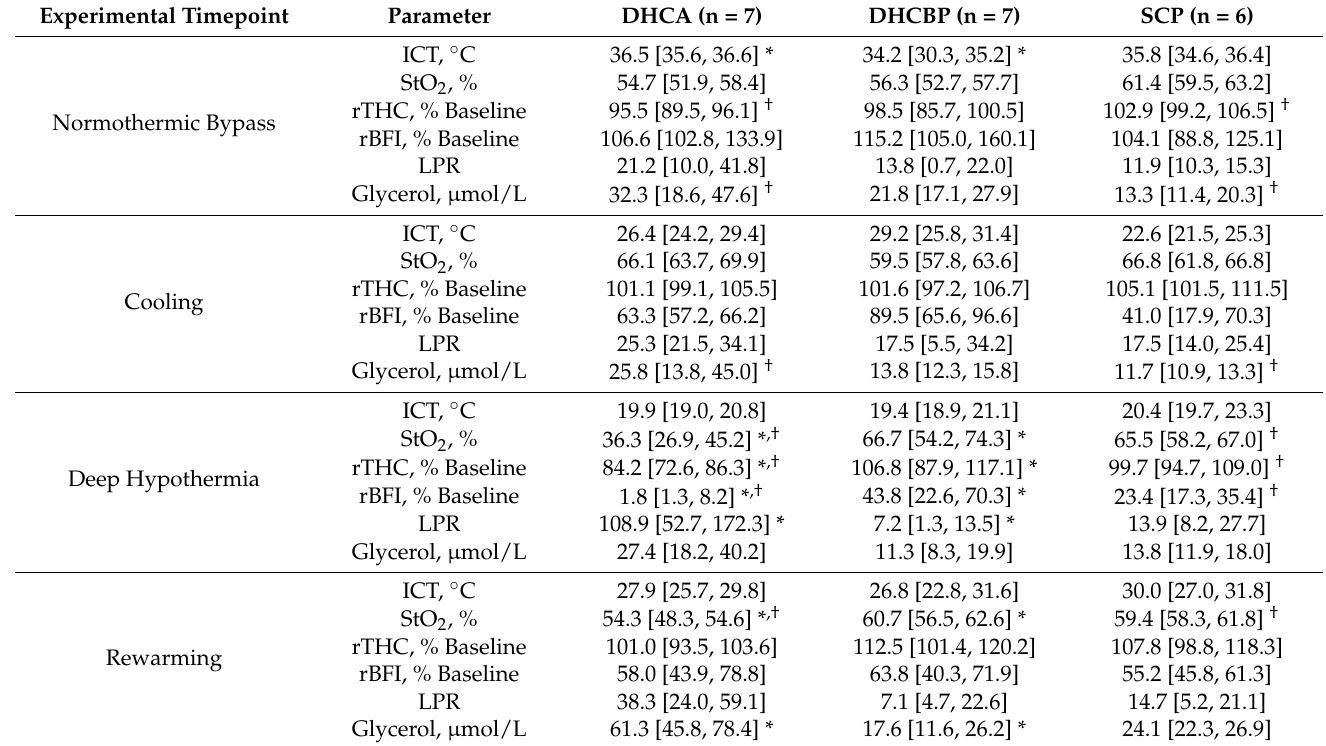
Table 1. Comparison of Cerebral Physiologic Parameters at Microdialysis Sampling Timepoints. Experimental